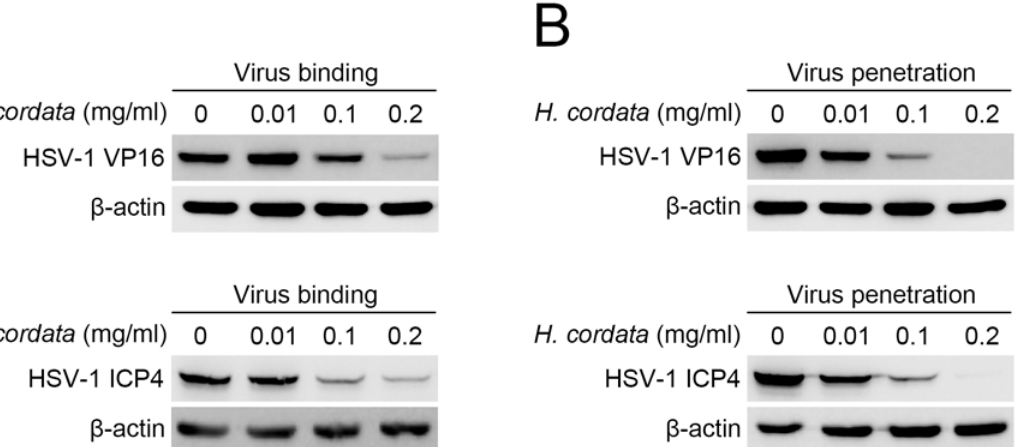
Figure 3. HCWEs inhibit HSV entry. HCWEs were added to Vero cells in virus binding (A) or penetration (B) stage as described in Fig. 2A and Fig. 2B. Nuclear extracts and total proteins were extracted from virus-infected cells and analyzed by Western blot assays with anti-VP16 and anti-ICP4 antibodies, respectively. β -actin was used as an internal control for protein loading.